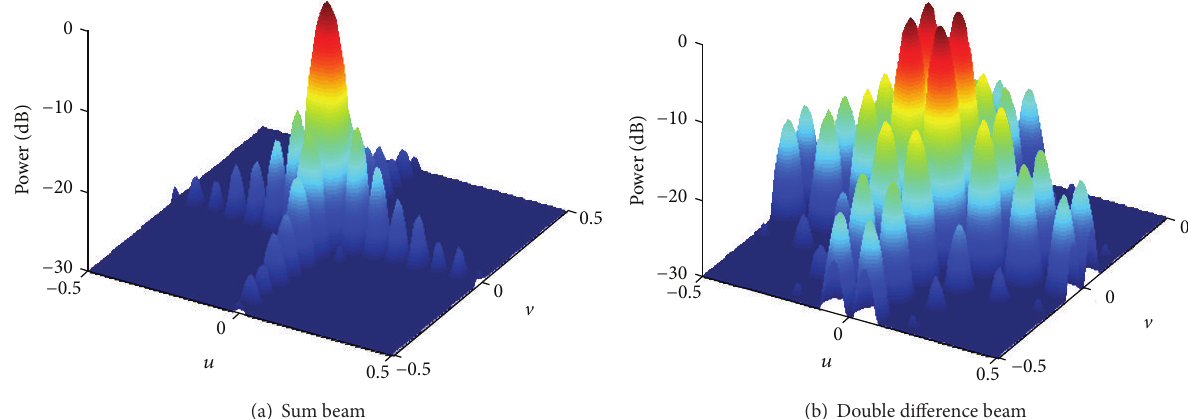
Figure 11: Patterns obtained by only analog weighting.